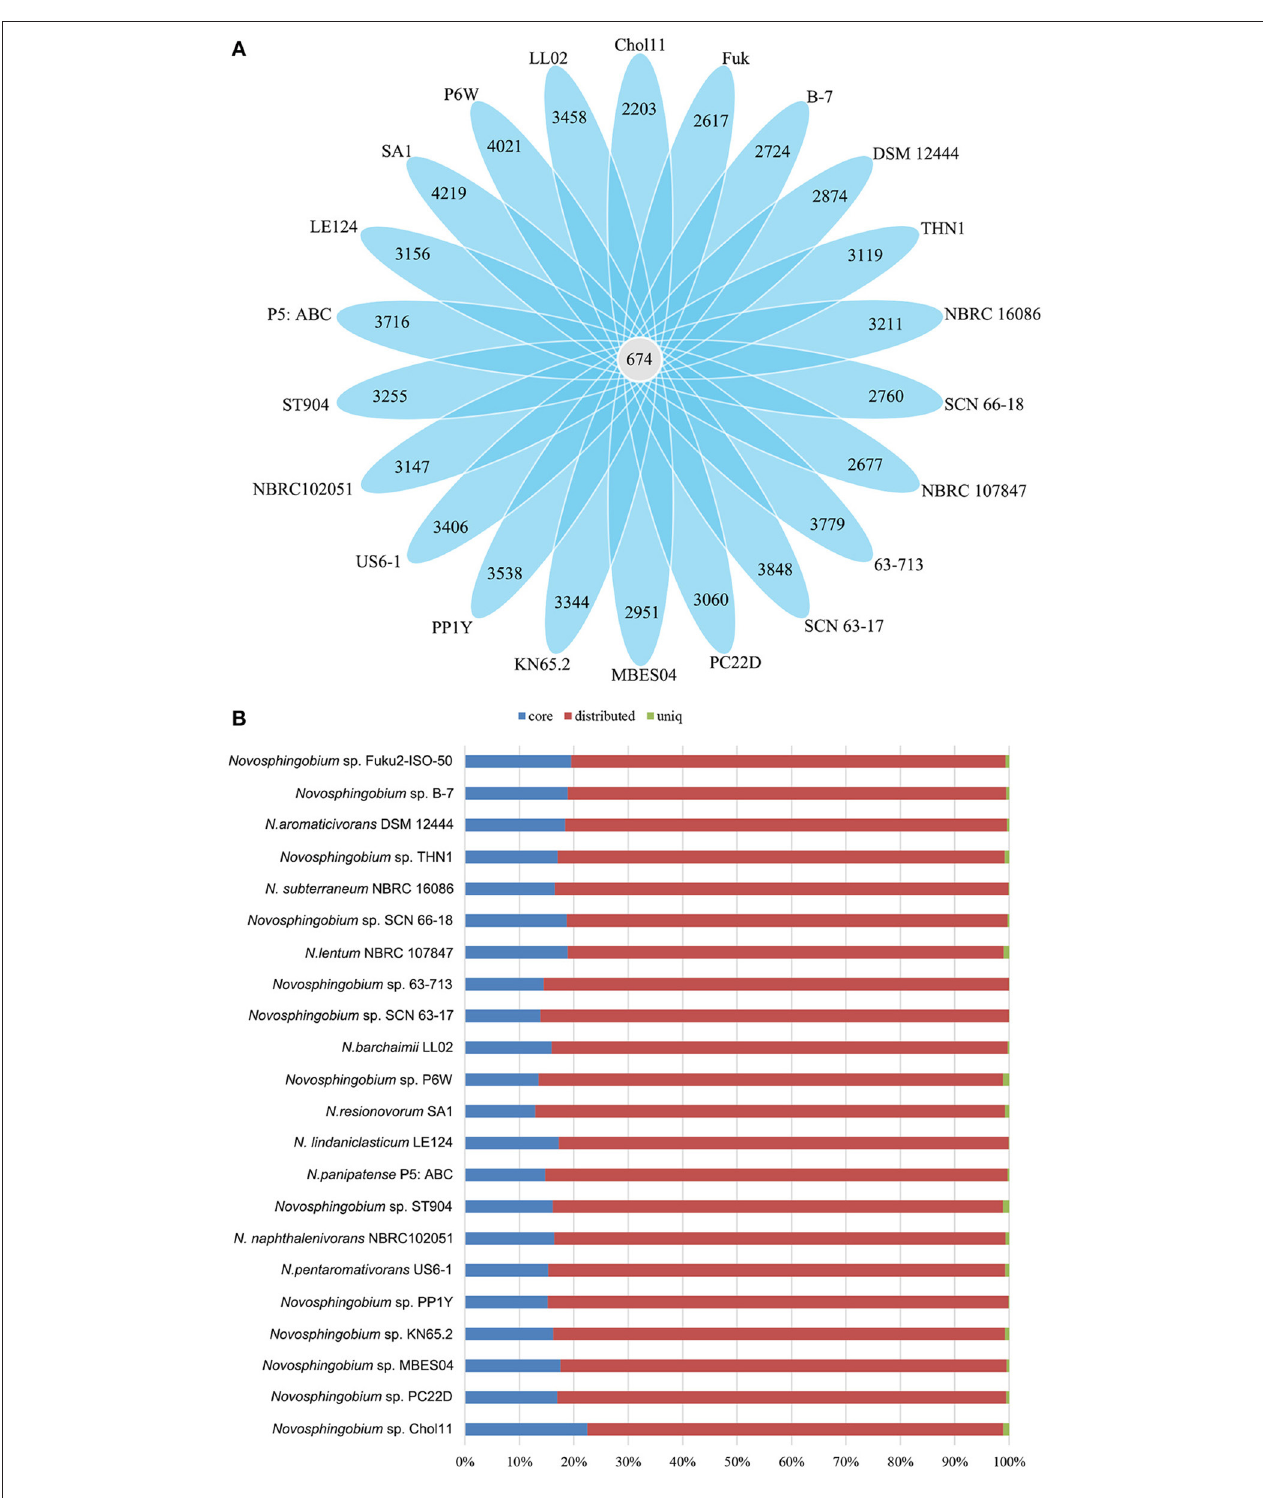
FIGURE 2 | Comparisons of Novosphingobium orthologous protein groups in 22 Novosphingobium genomes. (A) Venn diagram displaying the numbers of core gene families and flexible genes for each of the 22 Novosphingobium strains. (B) Percentage of core, distributed, and unique genes in each of the 22 genomes.